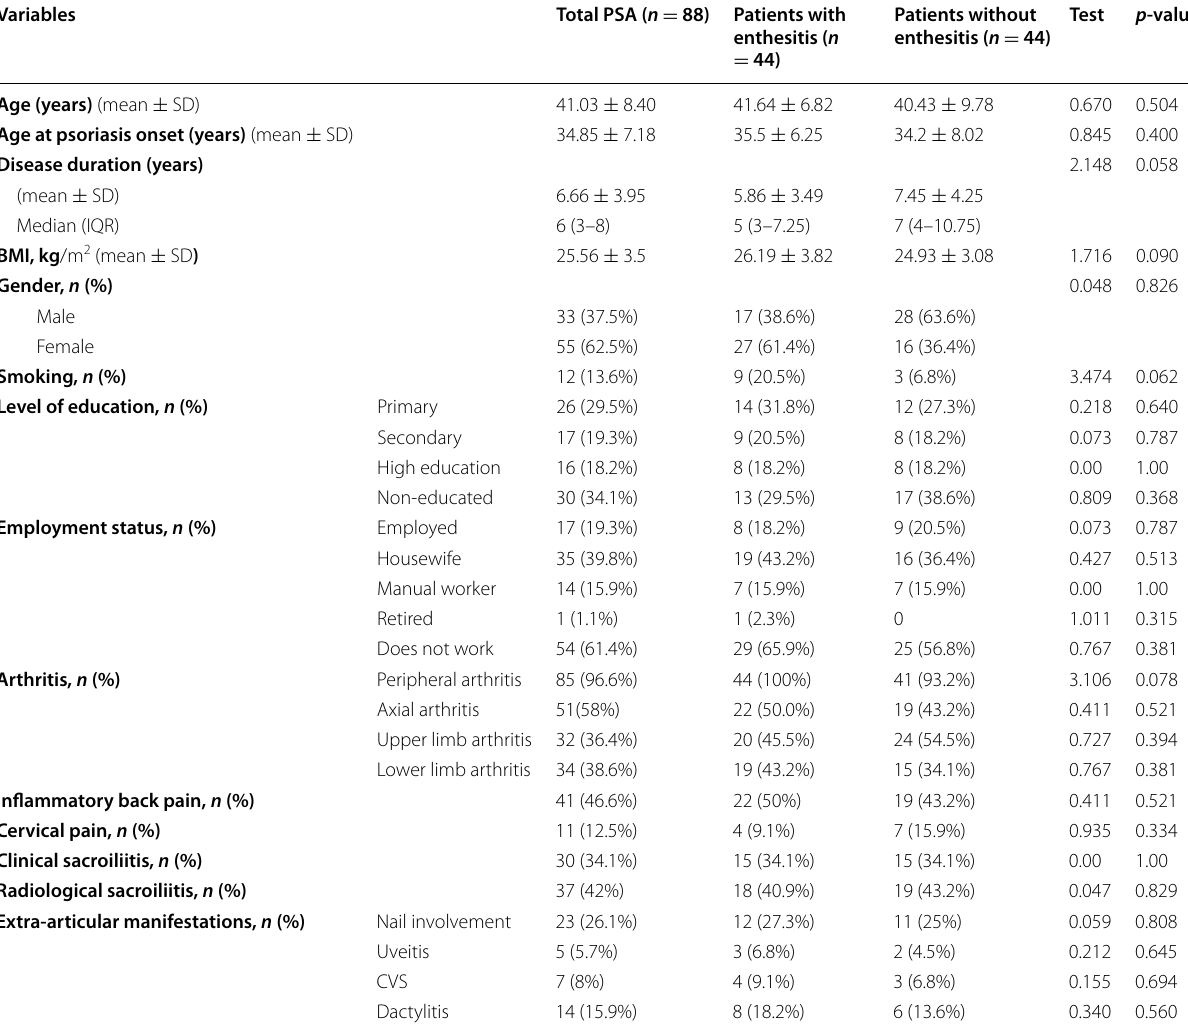
Table 1 Demographic, clinical characteristics of patients suffering from psoriasis-related enthesitis and those without enthesitis